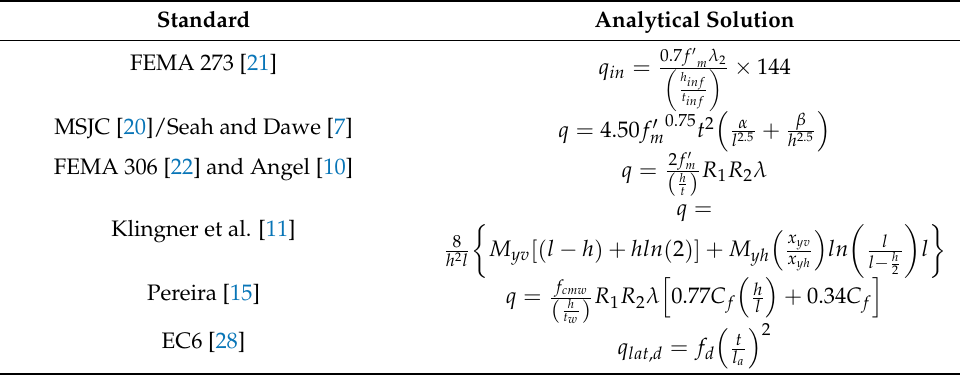
Table 6. Analytical solutions used to compute the out-of-plane capacity of the infill